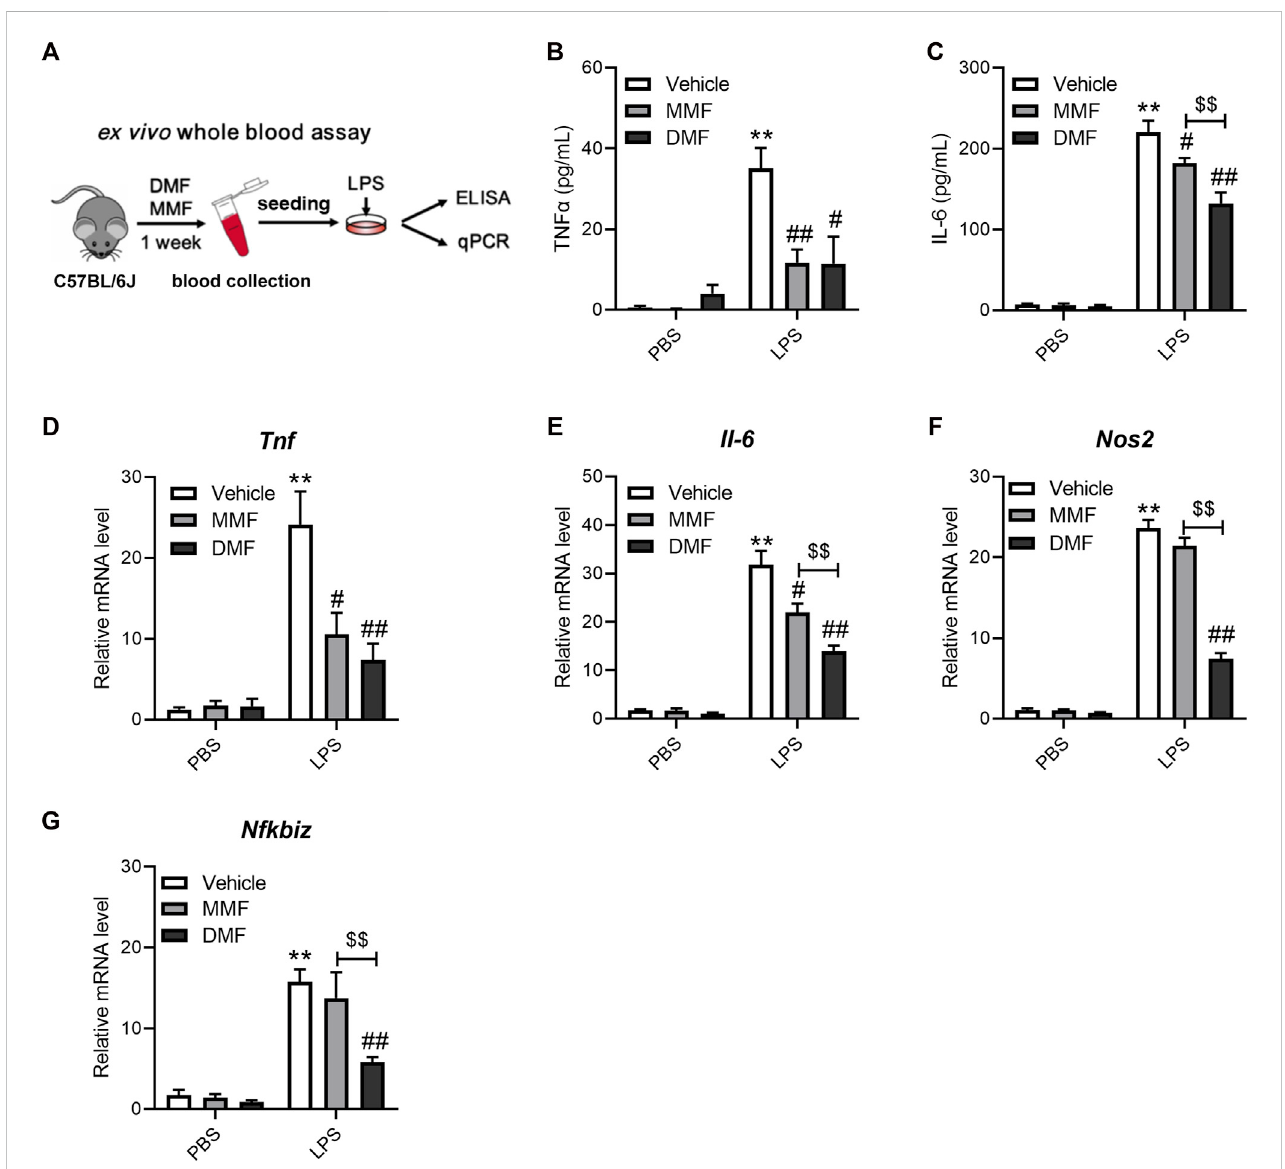
FIGURE 4 OraladministrationofDMFexhibitsdistinctanti-in fl ammatoryeffectsin exvivo wholebloodLPSstimulationassays. (A) Diagramofthestudydesign.Mice were orally administered DMF or MMF for 1 week, and blood samples were collected for ex vivo whole blood assays. (B,C) Peripheral blood cells stimulated with 1 μ g/mL LPS for 6 h ex vivo. ELISA analysis of TNF α (B) and IL-6 (C) in the indicated groups ( n = 7). (D – G) Peripheral blood cells stimulated with 1 μ g/mL LPS for 1 h. RT ‒ qPCR analysis of Tnf (D) , Il-6 (E) , Nos2 (F) and Nfkbiz (G) mRNA expression in the indicated groups ( n = 6 – 7). ** p < 0.01 vs. the untreated group by one-way ANOVA; # p < 0.05 , ## p < 0.01 vs. the LPS group by one-way ANOVA; $$ p < 0.01 vs. the indicated group by t